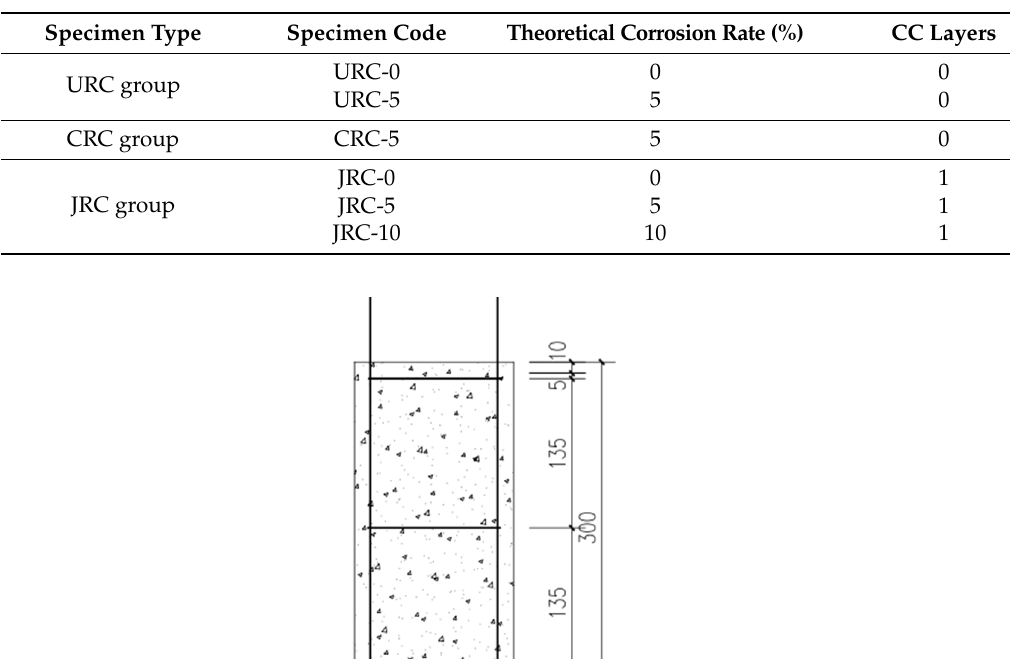
Table 2. Specimen parameters.